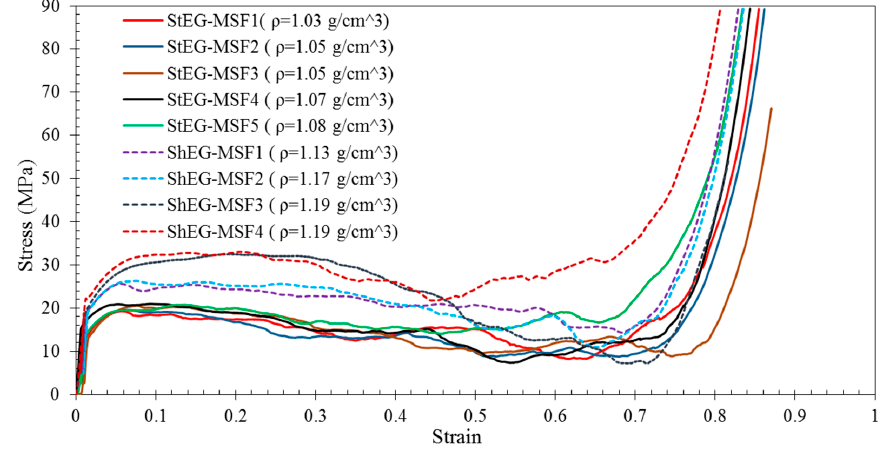
Figure 7. Compressive stress-strain curves for stable (solid lines) and shrunk (dashed lines)